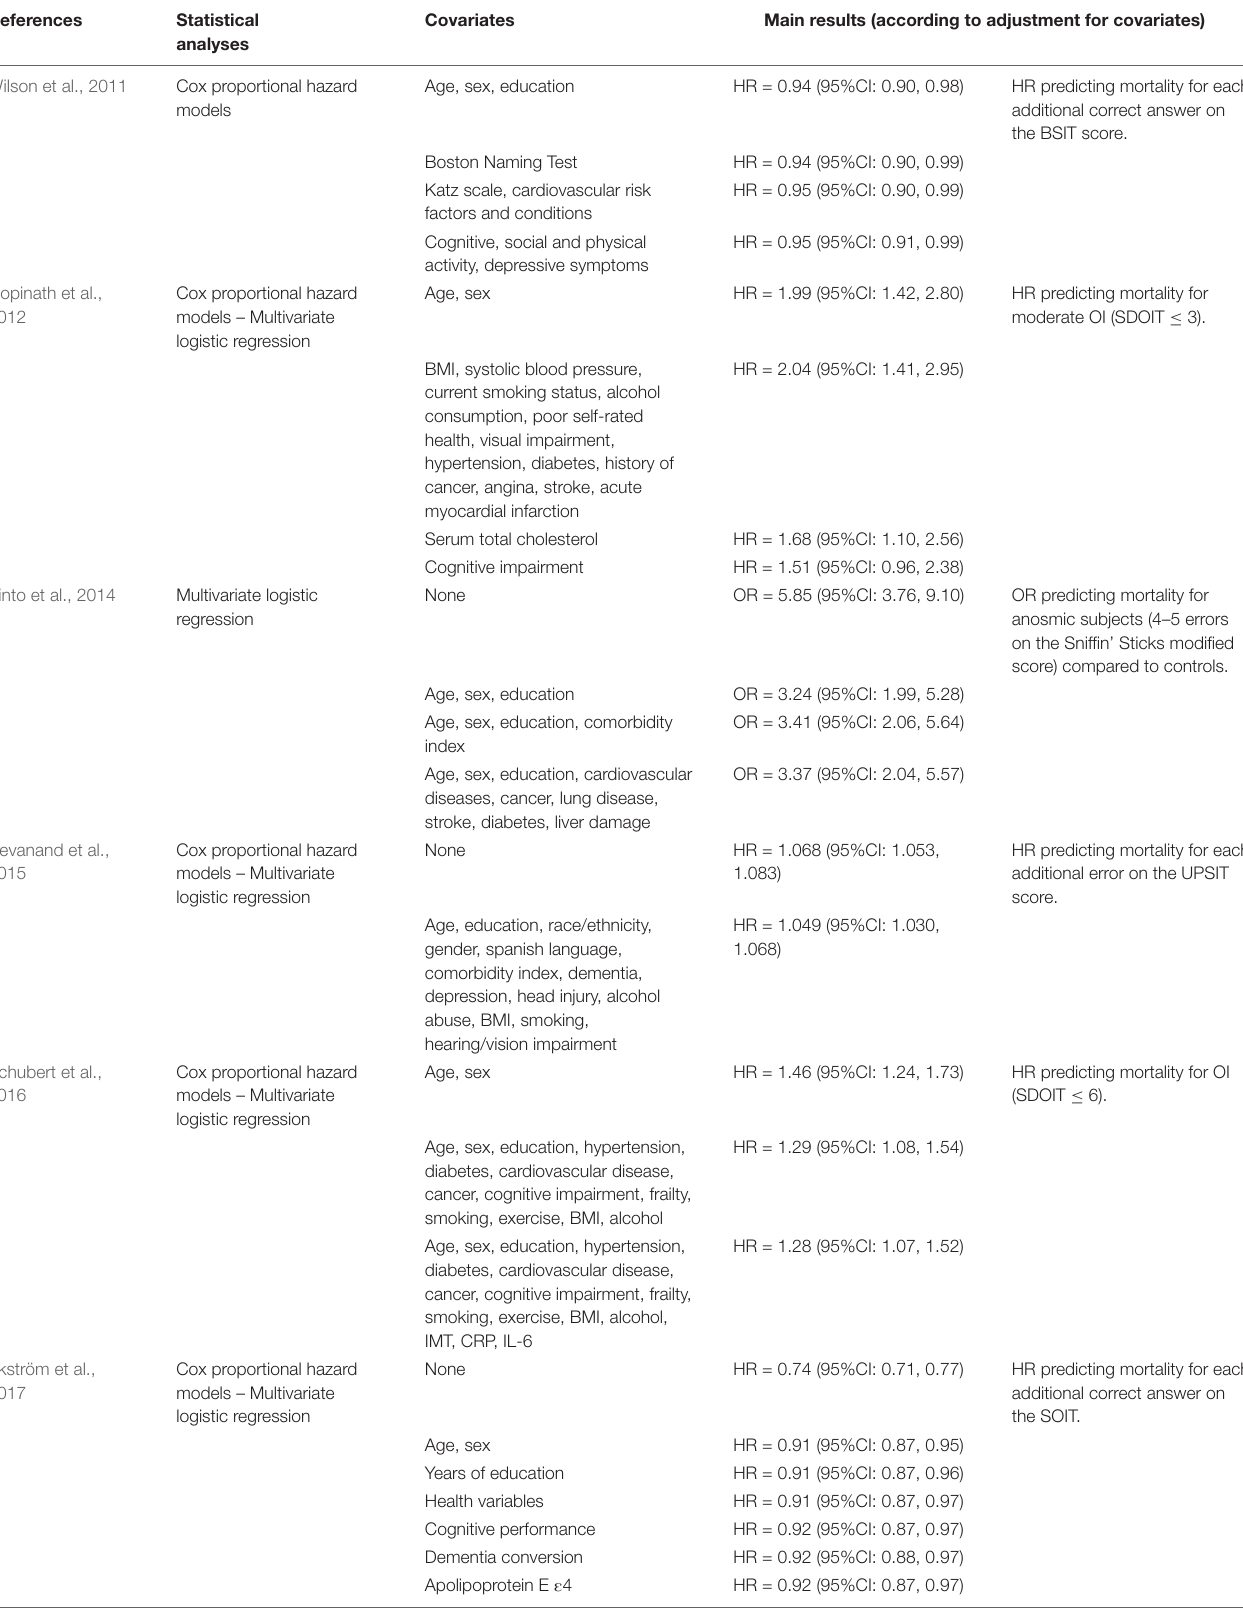
TABLE 2 | Studies linking olfactory impairment and mortality – Statistics and